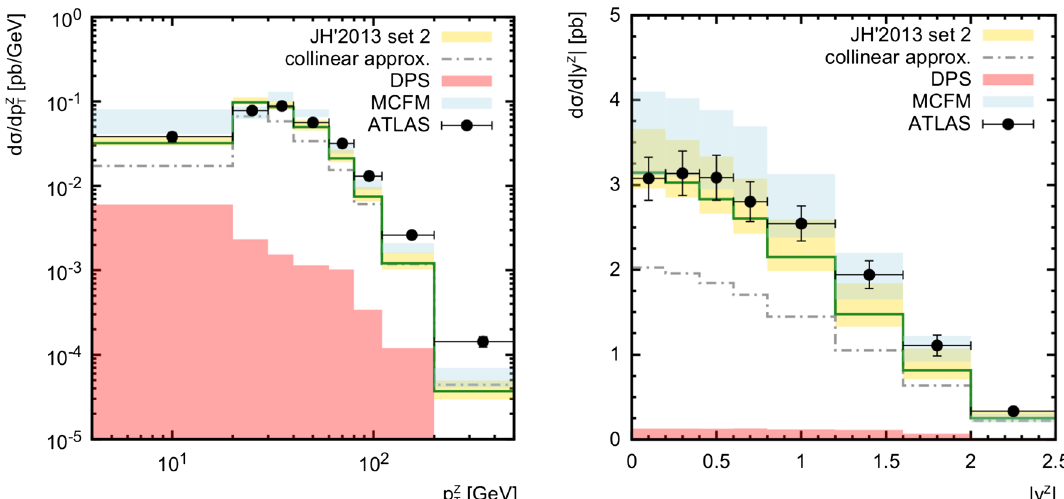
√ s = 7 TeV pre- described in the text. The dash-dotted histograms correspond to the collinear limit of our calculations. The estimated DPS contributions and mcfm [48–50] predictions (taken from [9]) are shown additionally. The data are from ATLAS [9]